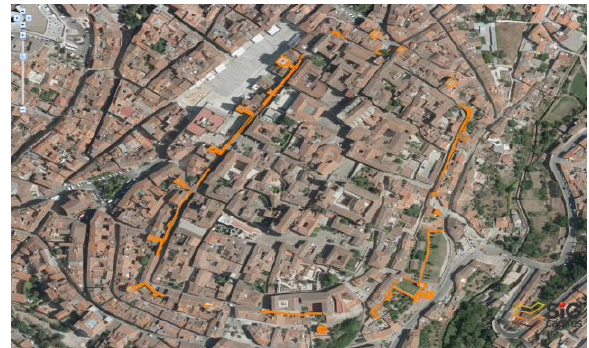
Figure 1. Walled city of Cáceres. Wall canvas preserved.